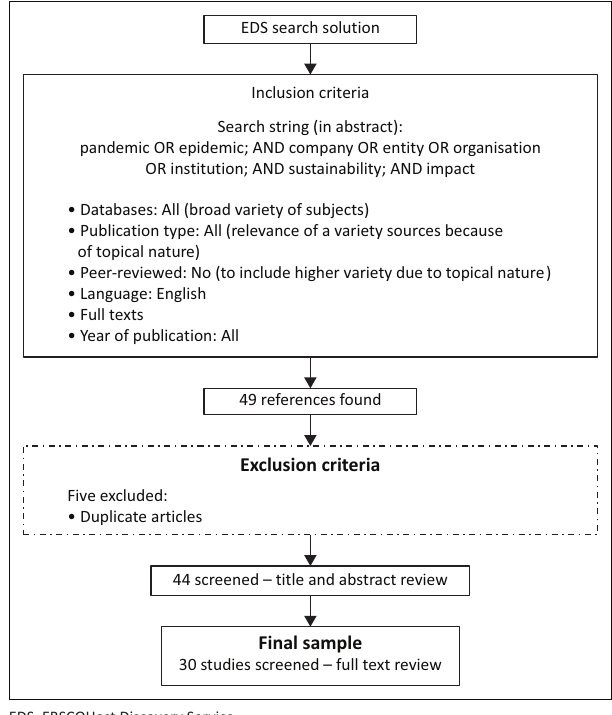
FIGURE 1: Illustrative representation of systematic review search strategy